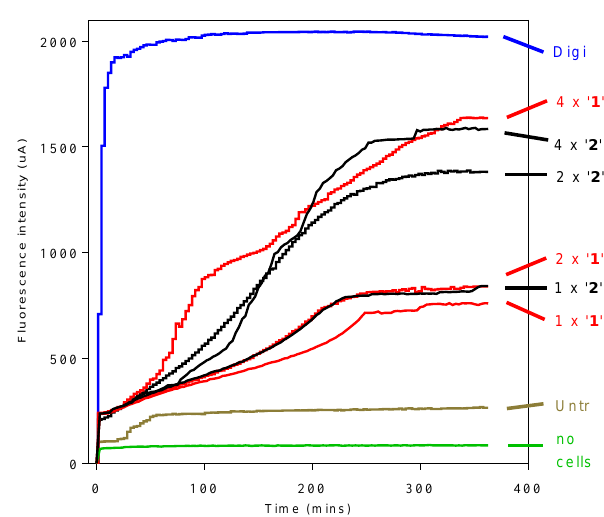
Figure 2. Speed of action profile of 3-aminosteroids. The profiles represent fluorescence intensity of nucleic acid–propidium iodide (PI) complex for T. b. brucei incubated with 1 (red traces) and 2 (black traces) at concentrations 1 × , 2 × and 4 × IC 50 values and controls: Digi, digitonin (blue trace; positive control for 100% cellular disruption); Untr, PI + untreated cells only (Tan trace); and no cell, PI background without cells (green trace, ‘no cells’).